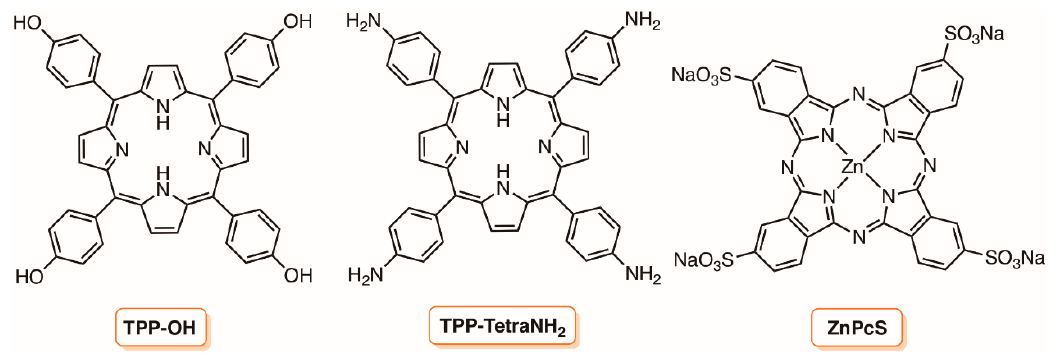
Figure 17. Structures of the porphyrins and phthalocyanine derivatives used by Bonnett and co-workers (adapted from Reference [106]).